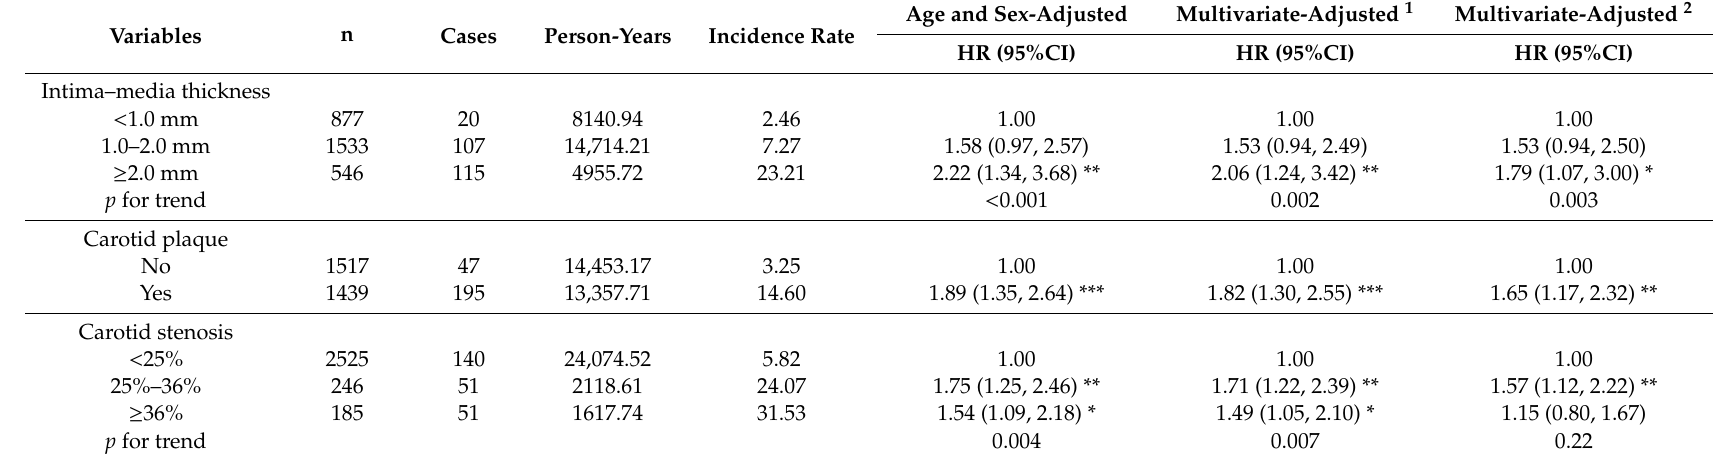
Table 2. Hazard ratios of all-cause mortality according to intima–media thickness, carotid plaque, and carotid